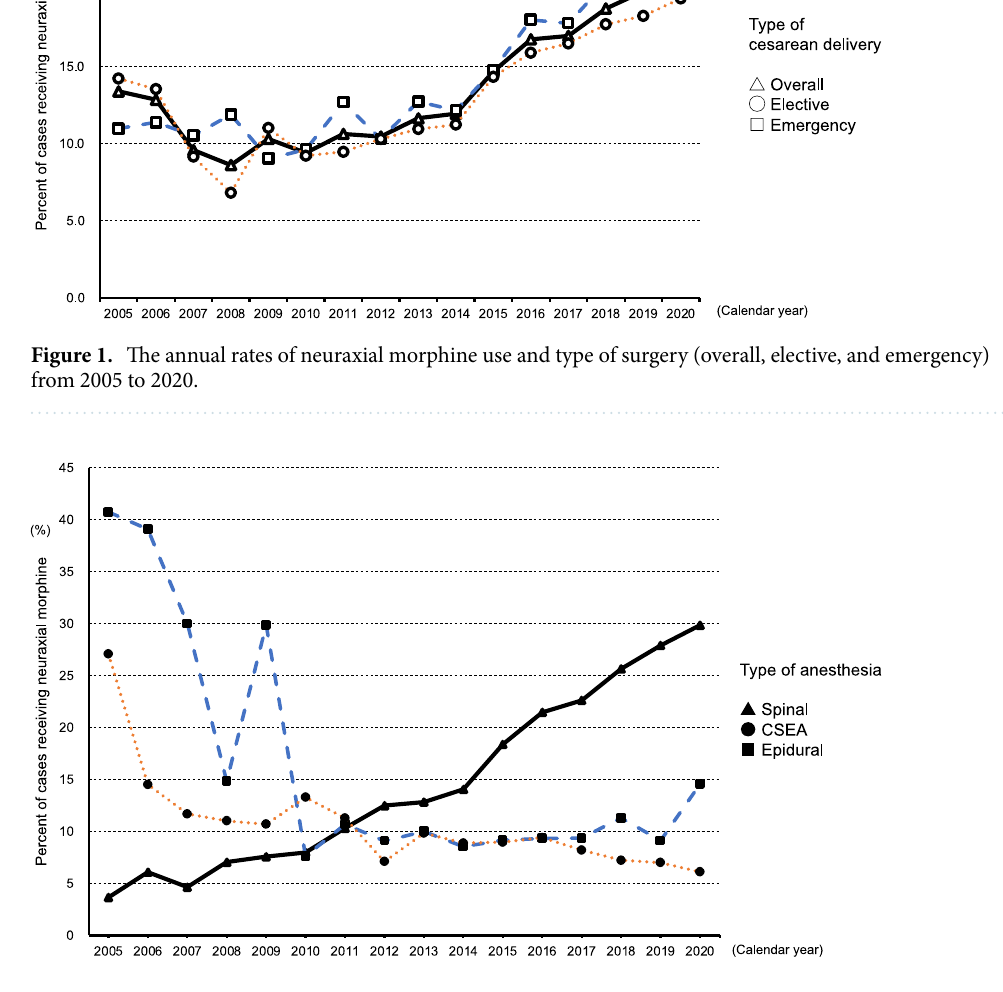
Figure 2. The annual rates of neuraxial morphine use and type of anesthesia (spinal, combined spinal–epidural anesthesia [CSEA], and epidural anesthesia) from 2005 to